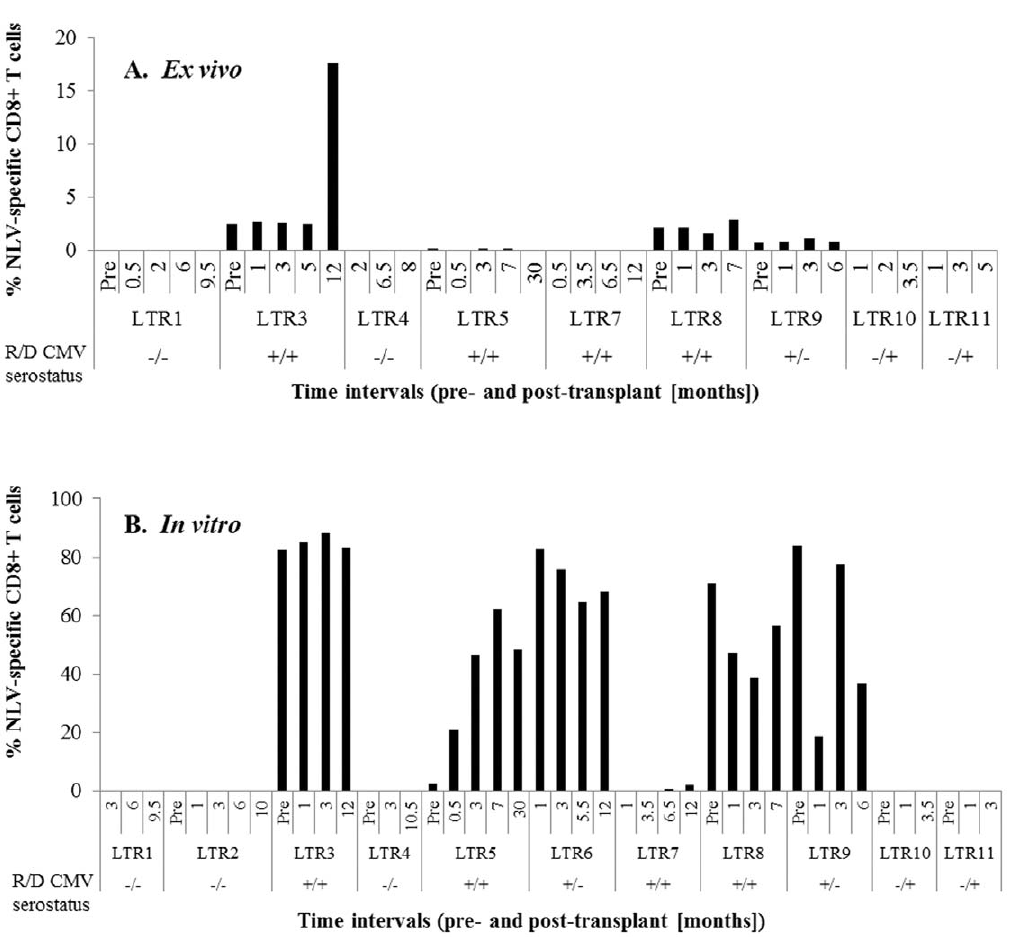
Figure 4. Expansion profiles of NLV-specific CD8 + T cells in LTR. NLV-specific CD8 + T cell frequencies were measured on day 0 (A) and after 13 days of NLV peptide stimulation (B) based on the total CD8 + T cell population, where available. CMV serostatus of the recipients and donors are indicated in the graphs.